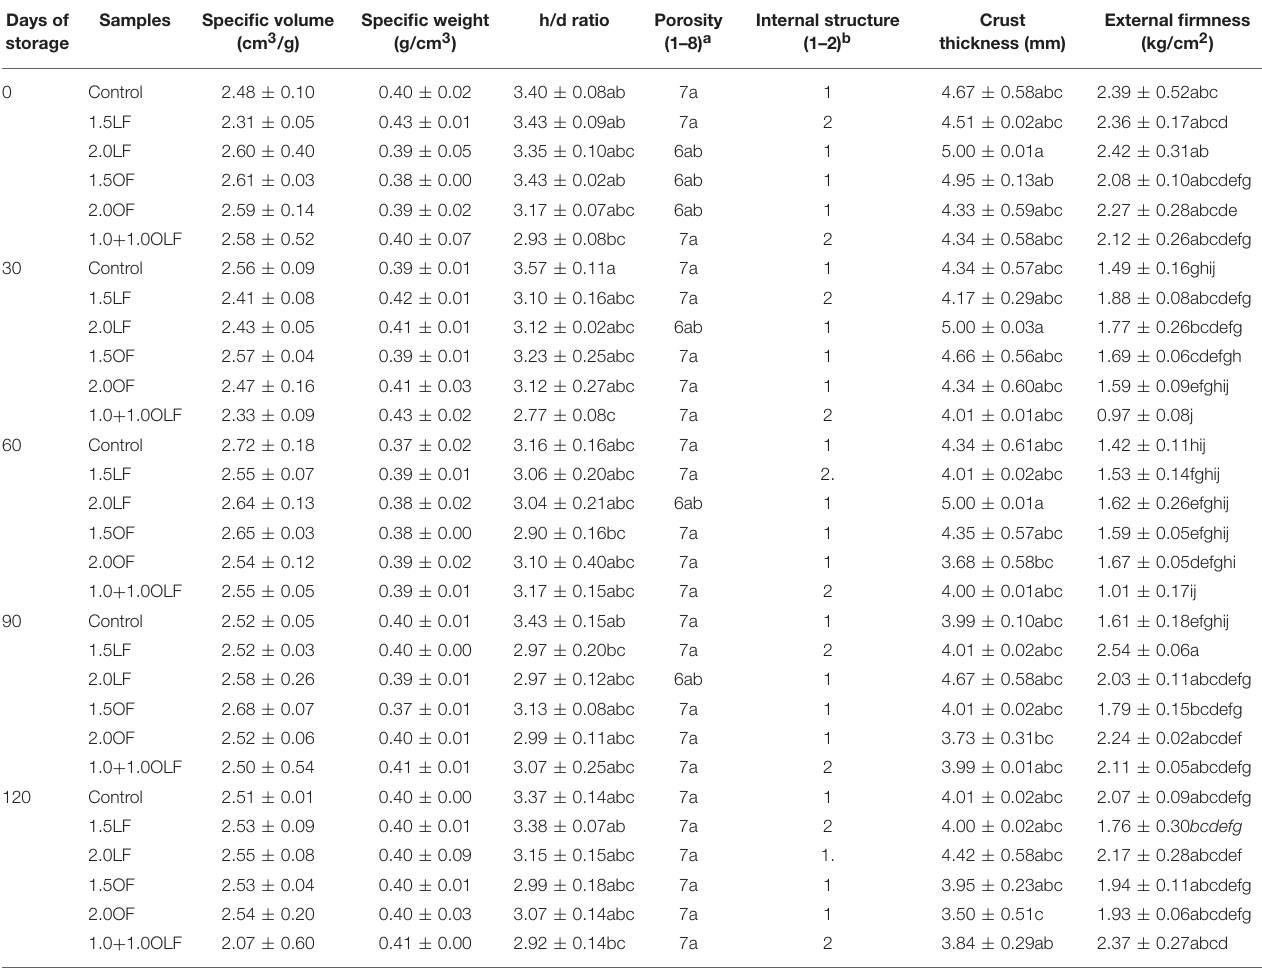
TABLE 5 | Evaluation of properties of bread samples produced using different levels of lemon (LF) and blood orange (OF) fibers, during storage. Days of